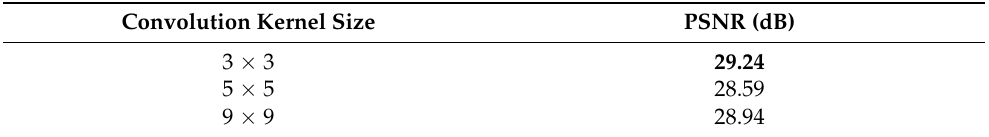
Table 3. Comparison of PSNR values of SRGAN reconstruction results with different convolution kernel